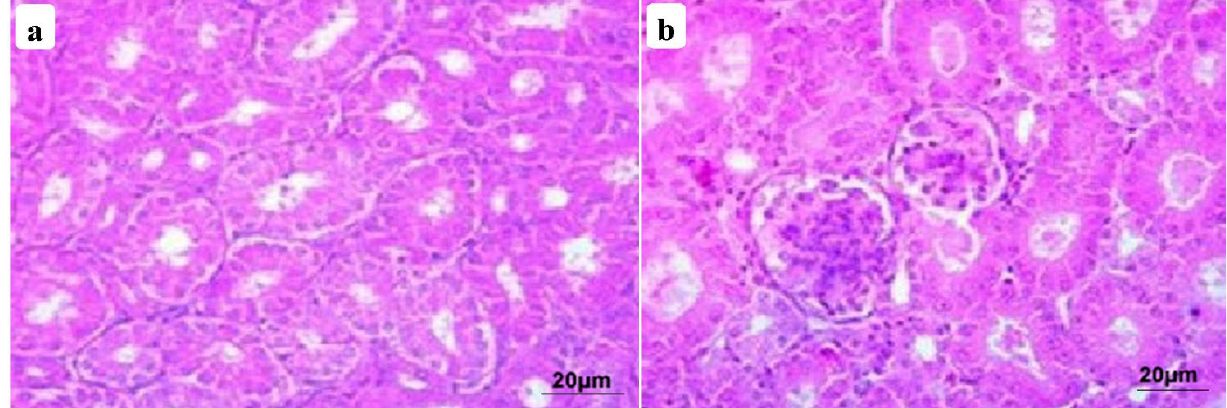
Figure 1. Photomicrographs of kidney sections from the control group at the 3rd week ( a ) and 6th week ( b ) showed normal histological structures.